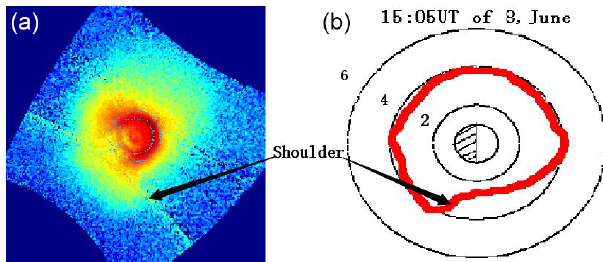
Figure 1. Snapshot of plasmasphere (a) by the EUV instrument, at 15:05UT of 8 June 2001, Sunlight is an incident from the upper right. Earth is in the center of panels and shoulder is observed and labeled in the snapshot. Panel (b) is plasmapause that is extracted from the left plasmaspheric image.